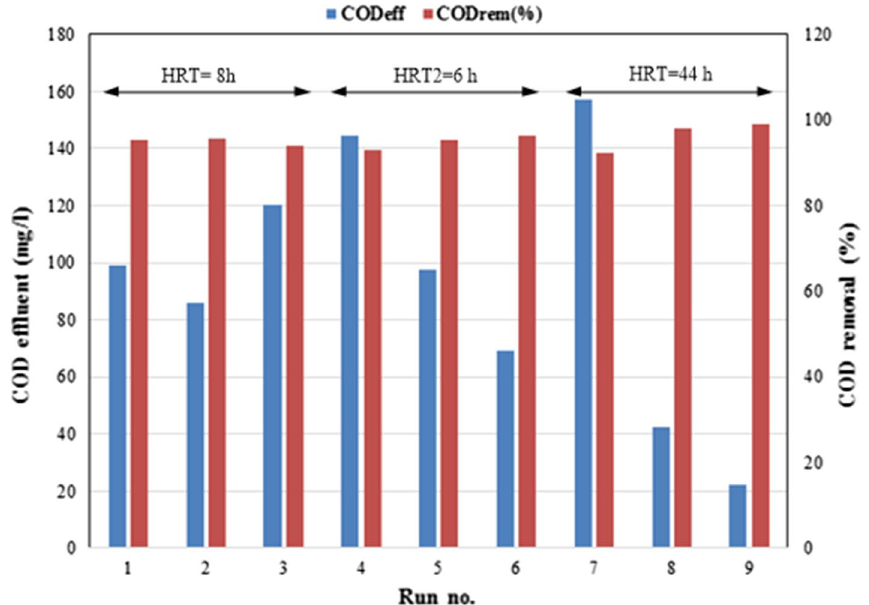
Fig. 2 COD removal at different operating